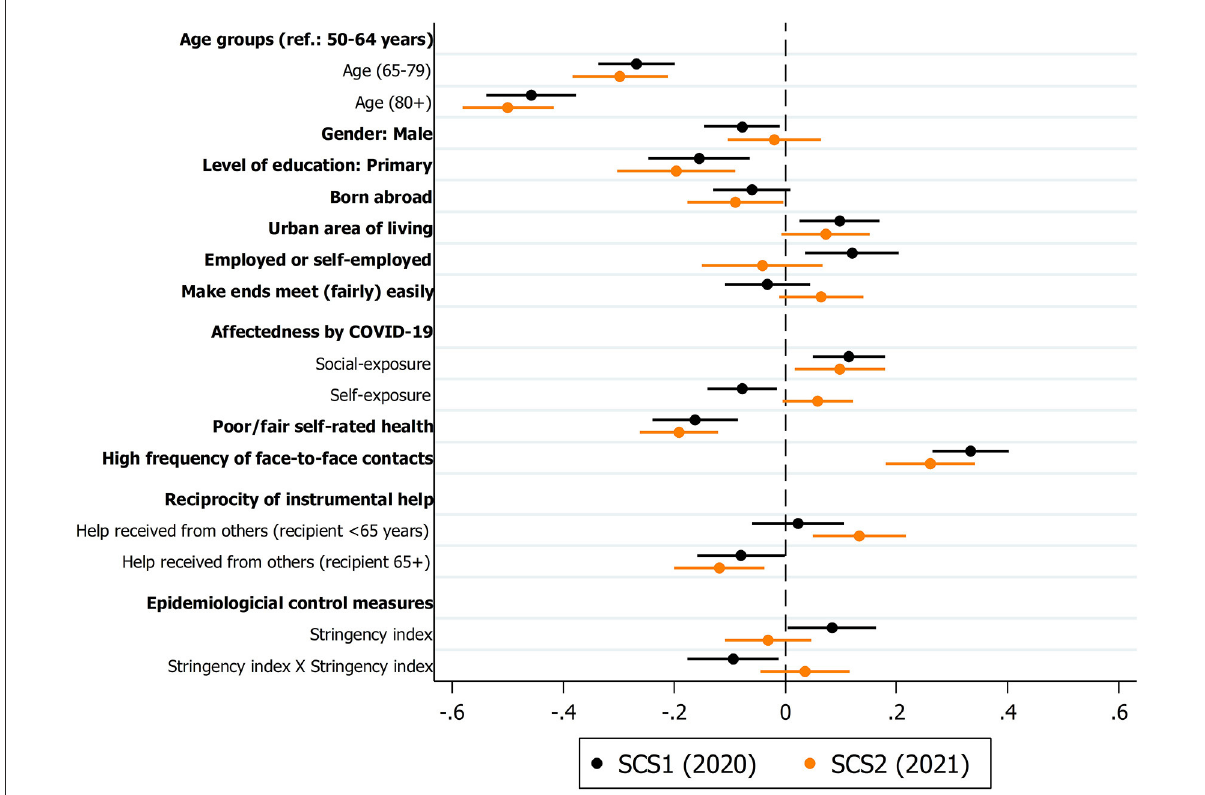
FIGURE4 Multivariate logistic regression coefficients of respondent and country predictors on providing instrumental help to others. Data: SHARE Wave 8 COVID-19 Survey 1 and SHARE Wave 9 COVID-19 Survey 2, Release 8.0.0 ( n = 42,918, respectively; weighted) with 95% confidence